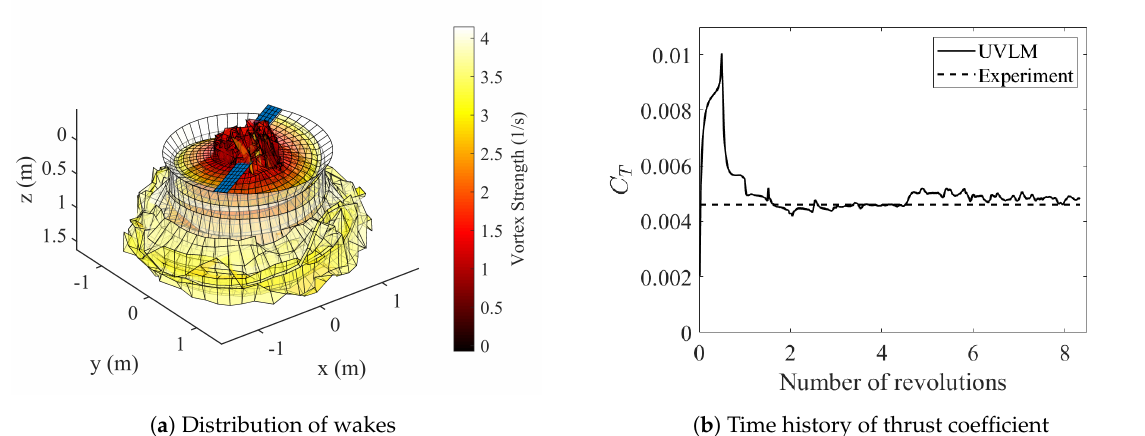
Figure 15. Simulation results of a propeller with wake–boundary interactions.